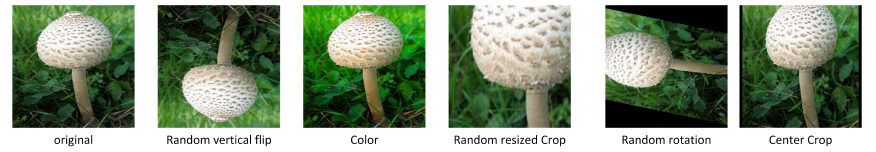
Figure 3. Images data